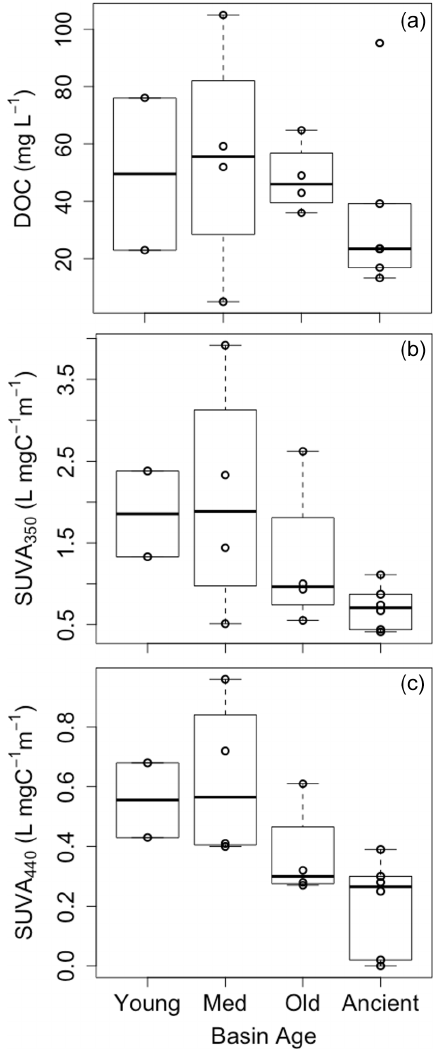
Figure 6. DOC concentration (a) , SUVA 350 (b) , and SUVA 440 (c) in deep porewaters versus DTLB age (young: < 50 years; medium: 50–300 years; old: 300–2000 years; and ancient 2000–5500